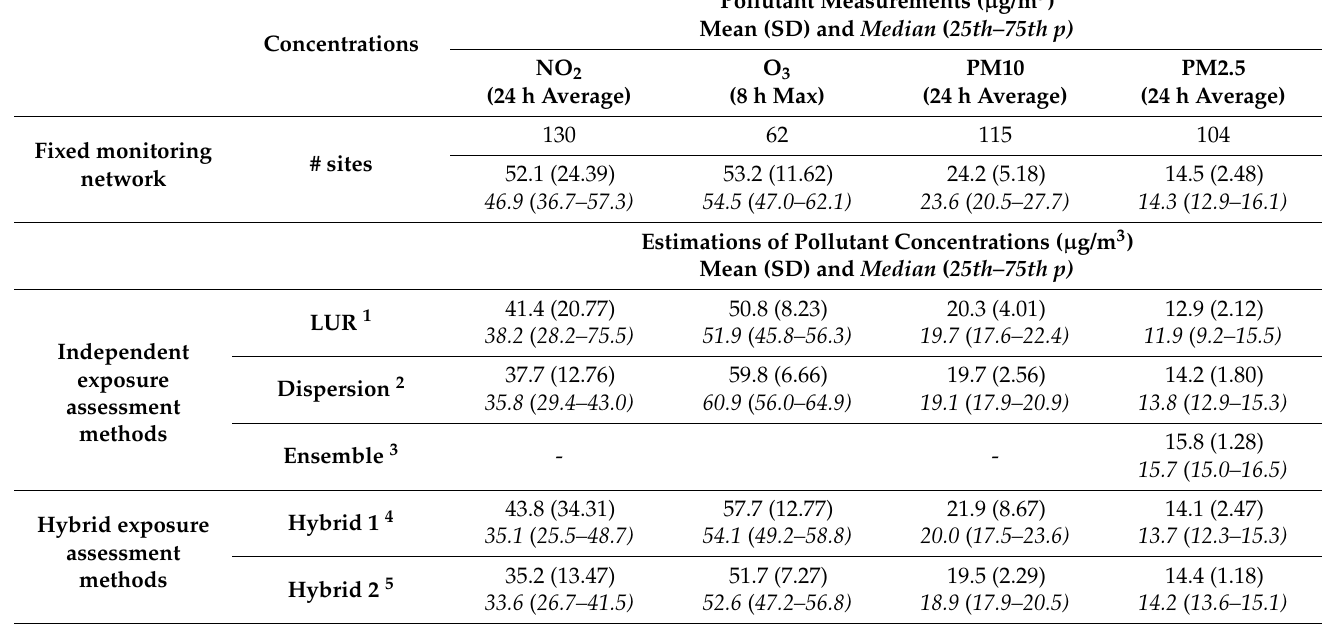
Table 1. Distribution of air pollutant concentrations measured from the fixed monitoring network and of estimated concentrations by the independent and hybrid exposure assessment methods, by pollutant, in the Greater London Area (n = 5373 LSOAs) for the years 2009–2013. Pollutant Measurements ( µ g/m 3 ) Mean (SD) and Median ( 25th–75th p) Concentrations NO 2 O 3 PM10 PM2.5 (24 h Average) (8 h Max) (24 h Average) (24 h